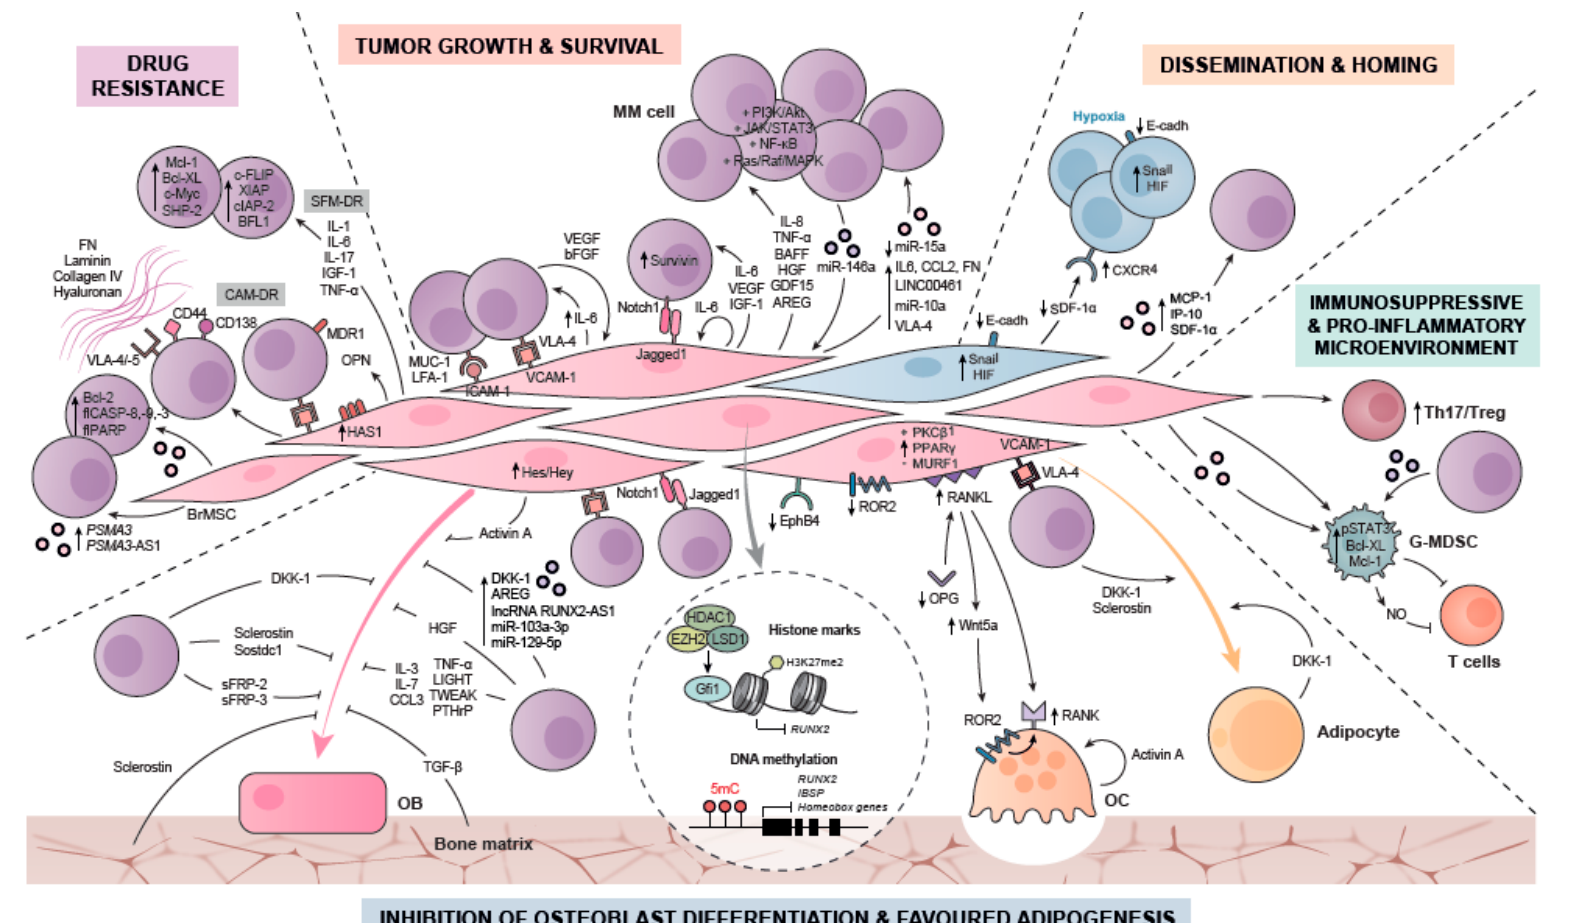
Figure 2. MSC- mediated biological activity in the BM microenvironment of MM. The MSC and myeloma cell cross-talk (through adhesion molecules, via soluble factors, or by extracellular vesicles derived from MM cells or MSCs) actively contributes to the pathology of the disease. The MSC—MM cell interactions increase MM growth and survival, induce drug resistance, promote myeloma dissemination and homing, support myeloma bone disease through impaired OB while favoured adipocyte differentiation and promotion of OC formation, and additionally contribute to a pro-inflammatory and immunosuppressive microenvironment.